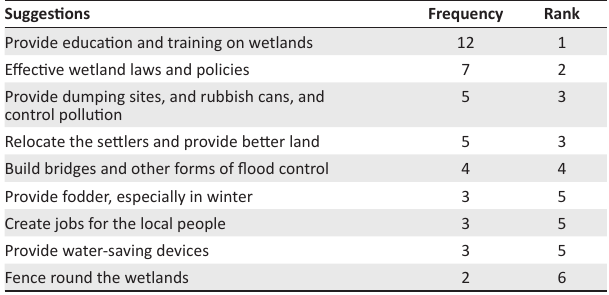
TABLE 9: Suggestions on how to better manage wetlands in the area from both private and communal users.